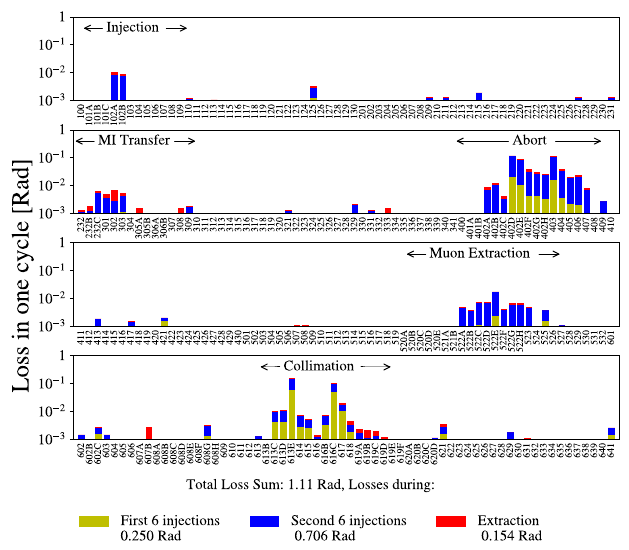
FIG. 8. Typical loss pattern after installing the two stage collimation system. Intensity is around 45 × 10 12